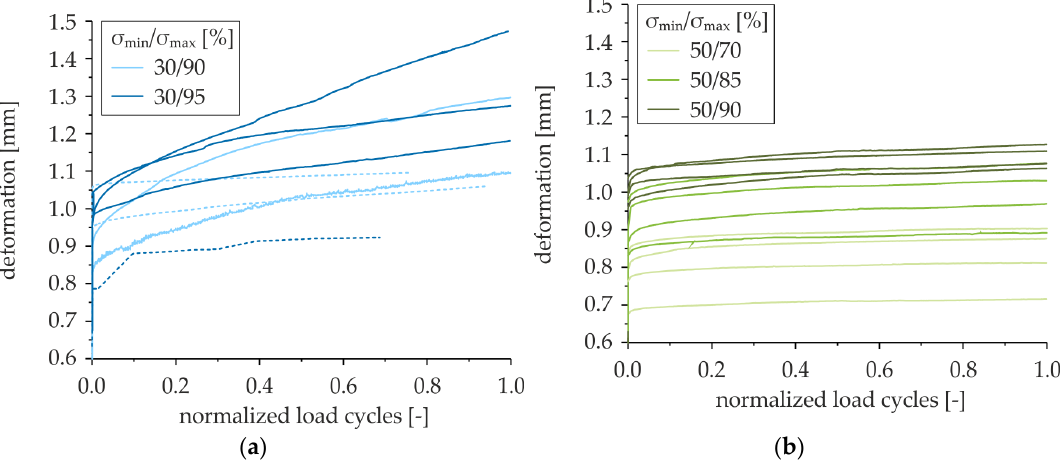
Figure 7. Comparison of normalized cyclic creep curves depending on the load level (here: anchorage length = 3 a ): ( a ) 30% minimum stress; ( b ) 50% minimum stress.